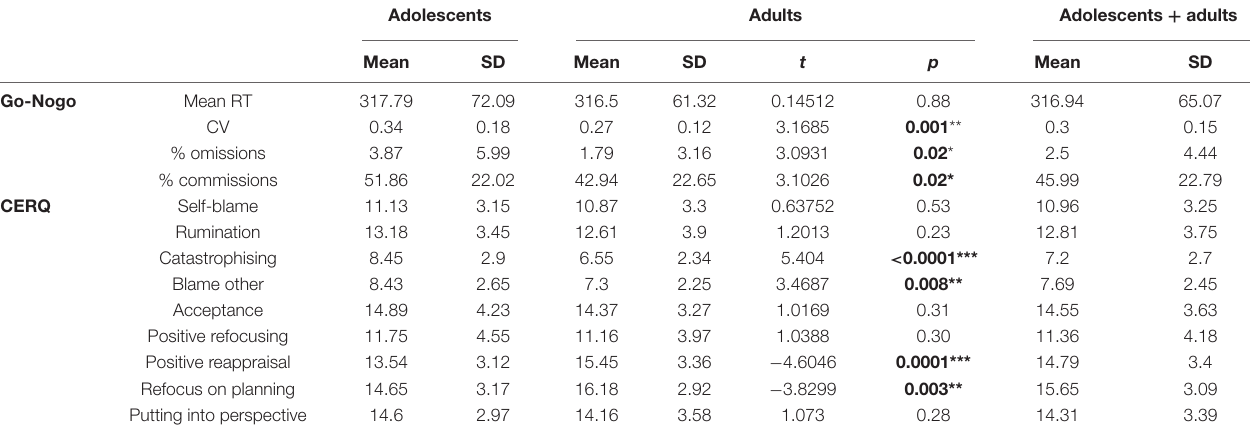
TABLE 1 | Descriptive statistics and corrected t-test results for age differences in measures of the Go-Nogo and